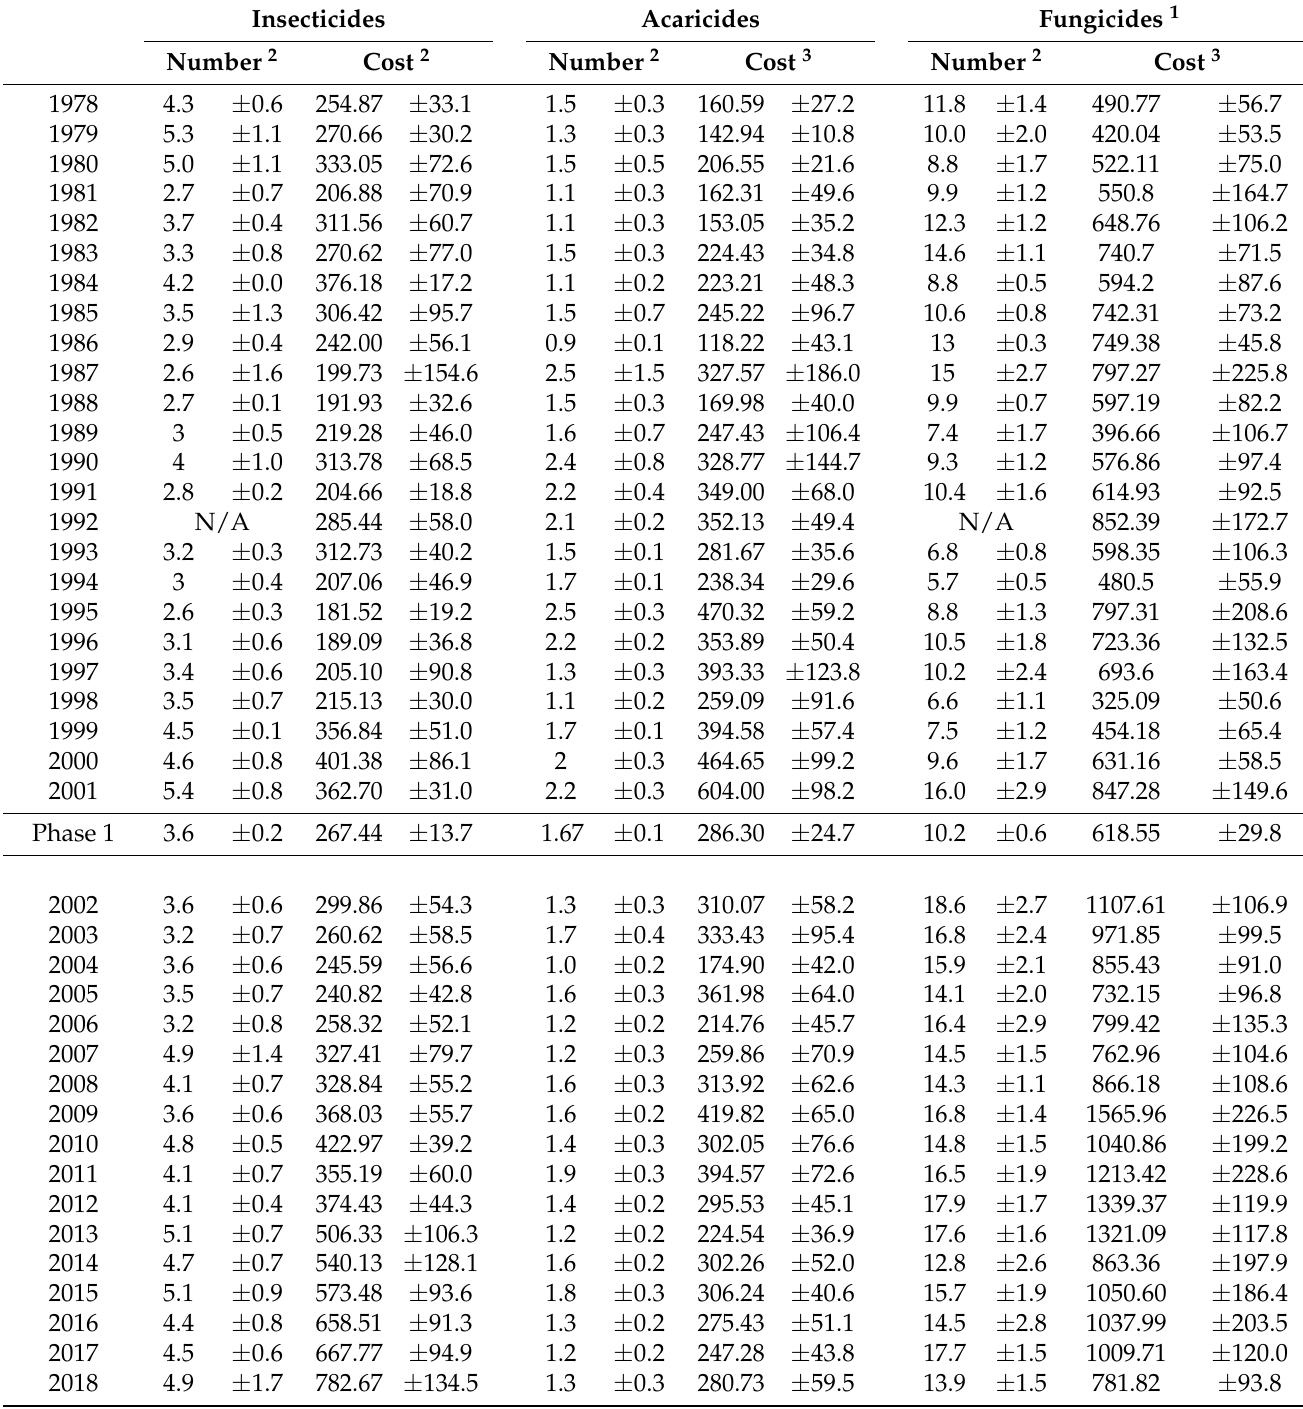
Table 3. Average number and cost ( ± standard error) of pesticide sprays per season in participating orchards. Commercial orchards located at Franklin, Hemmingford, Oka and Rougemont from 1978 to 2001 (Phase 1) and at Dunham, Franklin, Hemmingford, Oka, Saint-Joseph, Compton and Sainte-Famille from 2002 to 2019 (Phase 2). Phase 1: average